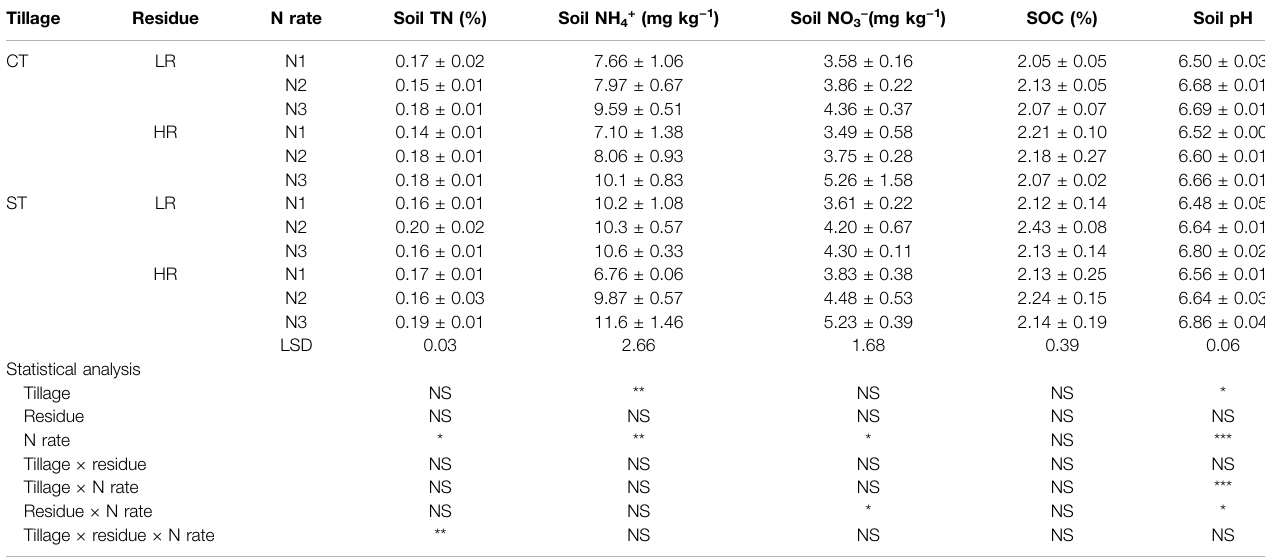
TABLE 4| Effect of tillage systems (conventional tillage, CTand strip tillage, ST), residue levels (low residue, LR and high residue,HR) and Napplication rates(108, 144, and 180 kg ha − 1 ) on soil organic carbon (SOC), total and mineral N, and pH ( n = 3; mean ± SE).